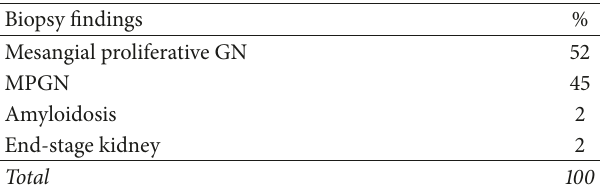
Table 5: Light microscopy renal biopsy